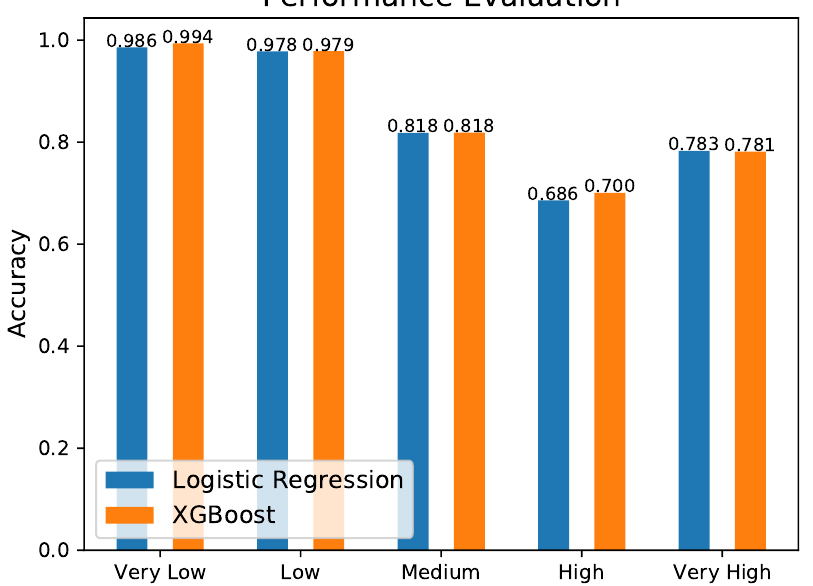
Figure 10. Comparison of Accuracy Level obtained with logistic regression and